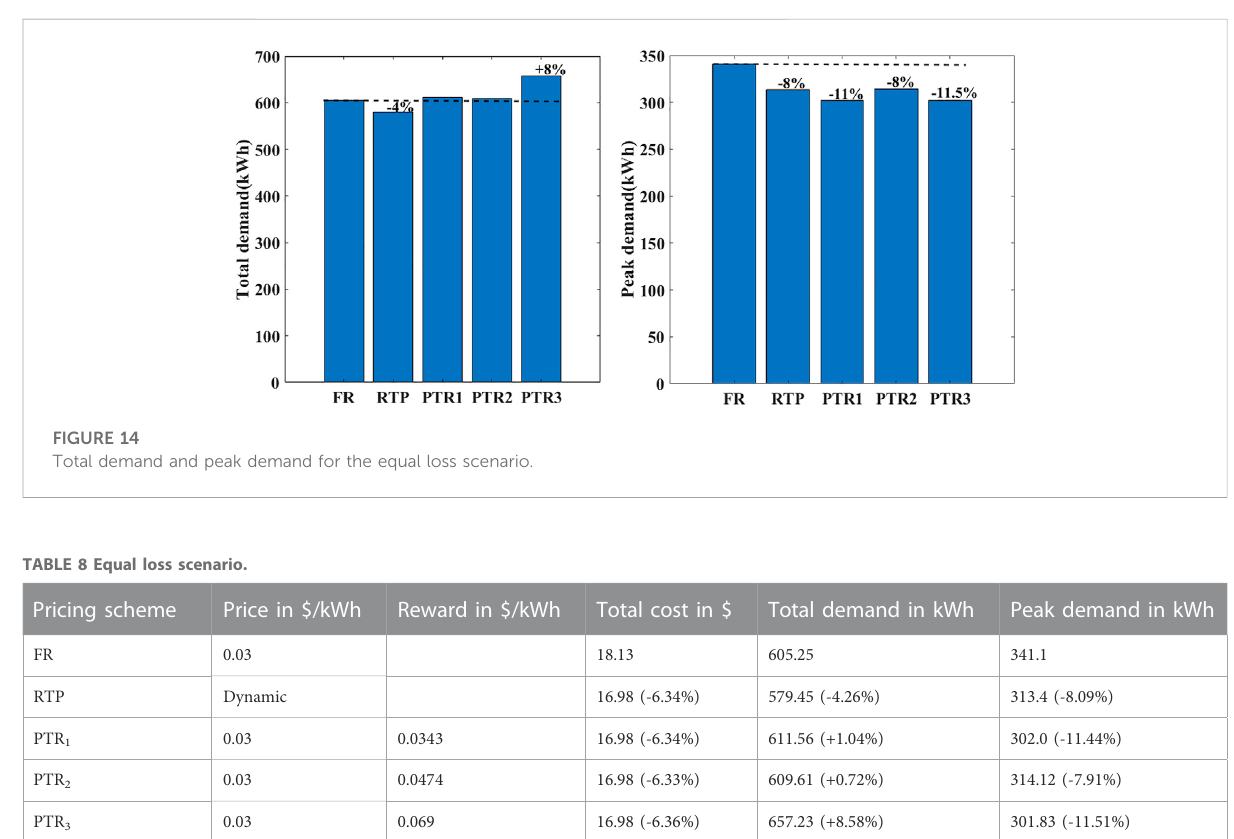
Figure 14. The implications of equal loss scenario and peak reduction scenario on the parameters are listed out in Tables 8, 9 respectively.